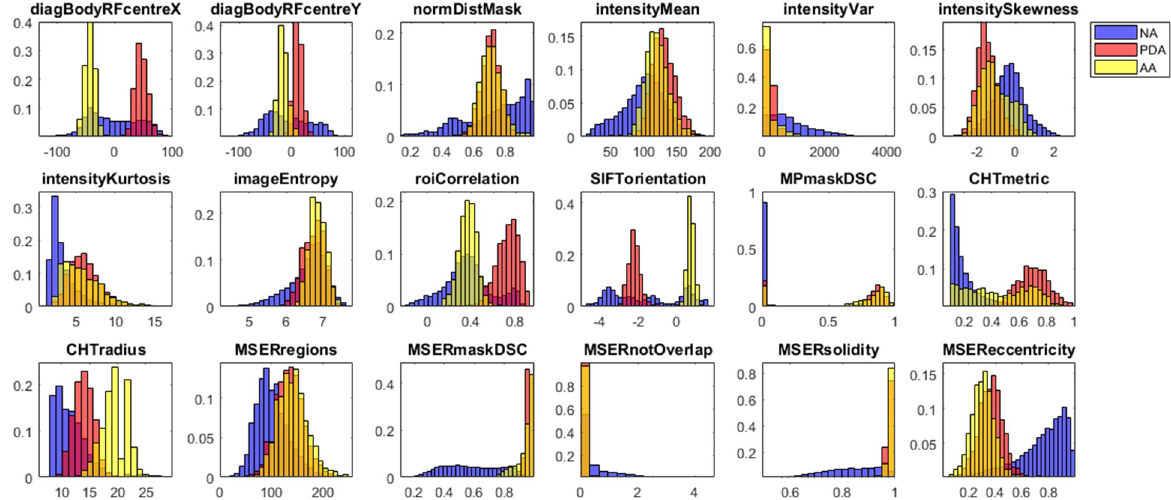
Fig 5. Histograms of image features. ROIs classified as Ascending Aorta (AA), Proximal Descending Aorta (PDA) or Not Aorta (NA). Total number of scans in the training dataset = 1200.